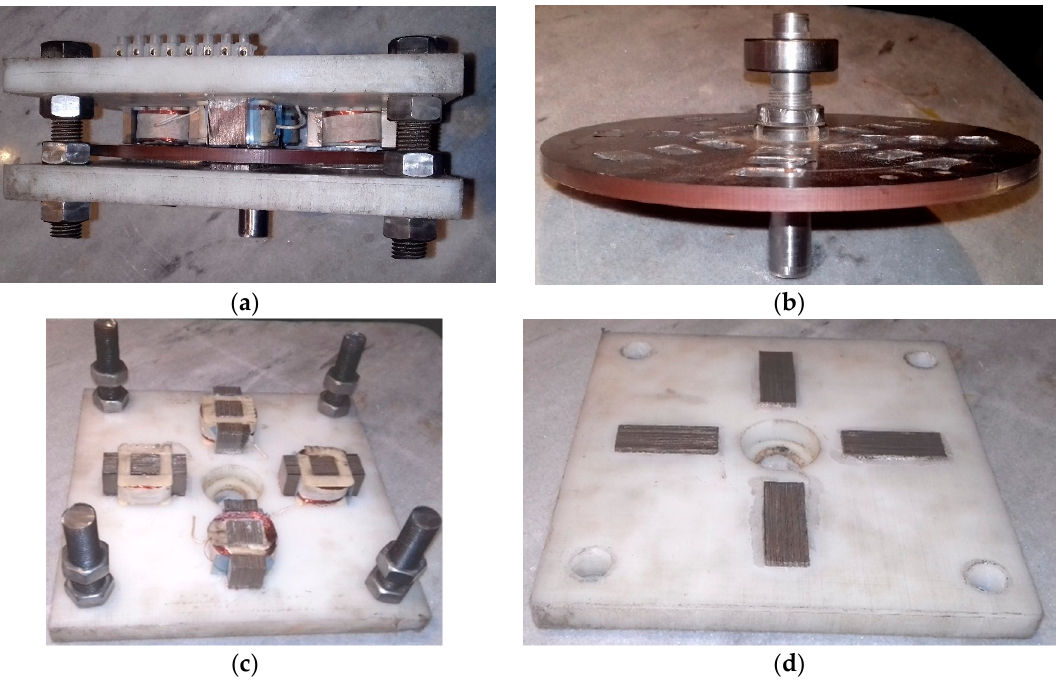
Figure 15. ( a ) Fabricated TFPMDEIG; ( b ) rotor disk; ( c ) stator body (E core); ( d ) stator body (I core).